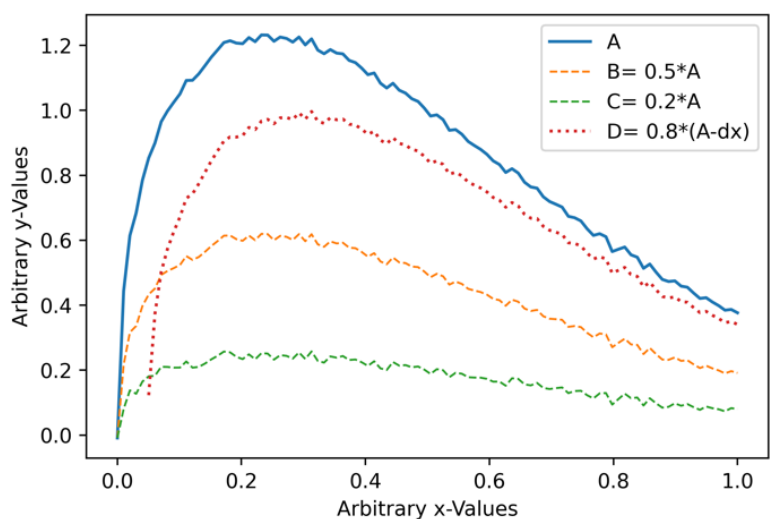
Figure 4. Visualization of the importance of the different fitment conditions. Dataset A is a proxy for the solar irradiance spectrum, and three transformations of this dataset are shown as proxies for an LHE spectrum (i.e., B, C and D). Dataset D is likely the optimal LHE spectrum in this case, but due to the small rightward shift, will exhibit a lower correlation than either datasets B or C. The three fitment conditions in Equations (10)–(12) are intended to account for such scenarios.